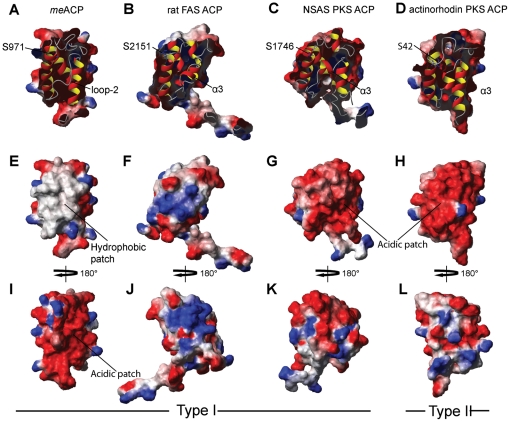
Embedded ribbon representation and electrostatic potential surface of ACPs.Type I meACP (A, E and I), rat FAS ACP (B, F and J, PDB ID: 2PNG), NSAS PKS ACP (C, G and K, PDB ID: 2KR5) and Type II actinorhodin PKS ACP (D, H and L, PDB ID: 1AF8). The invariant Ser is shown as blue stick and labeled. The protein surfaces are colored as white (hydrophobic), blue (basic) and red (acidic) with the same electrostatic potential scale.